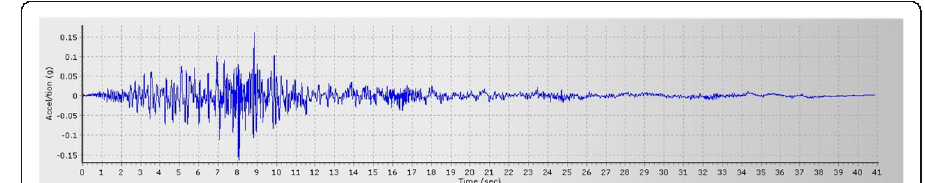
Fig. 12 Artificial accelerogram